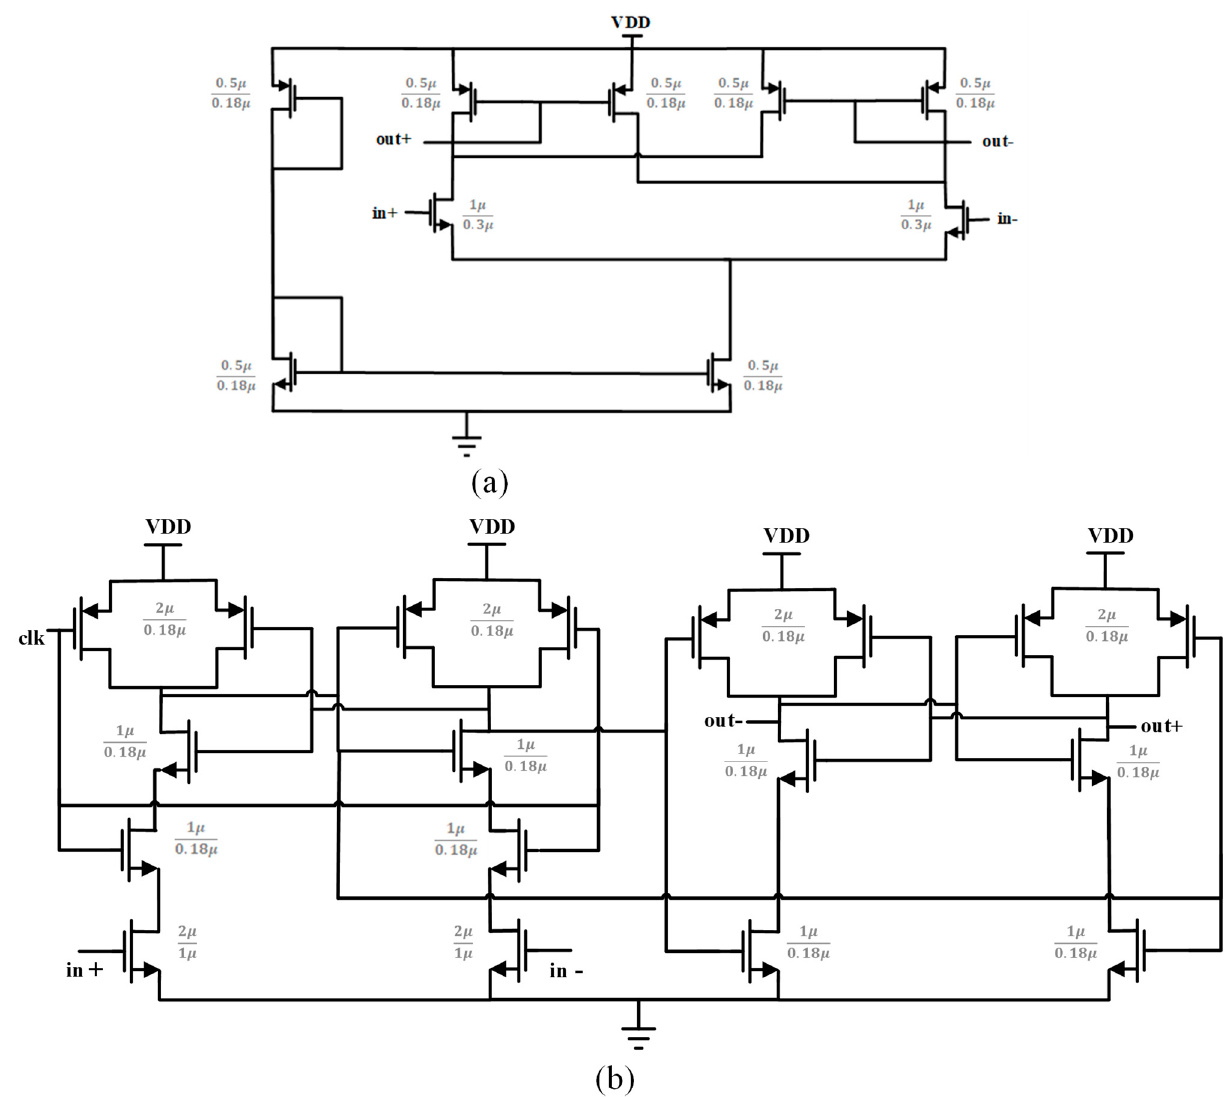
Figure 16. Circuits of the applied single-bit quantizer: ( a ) preamplifier and ( b ) comparator and latch.